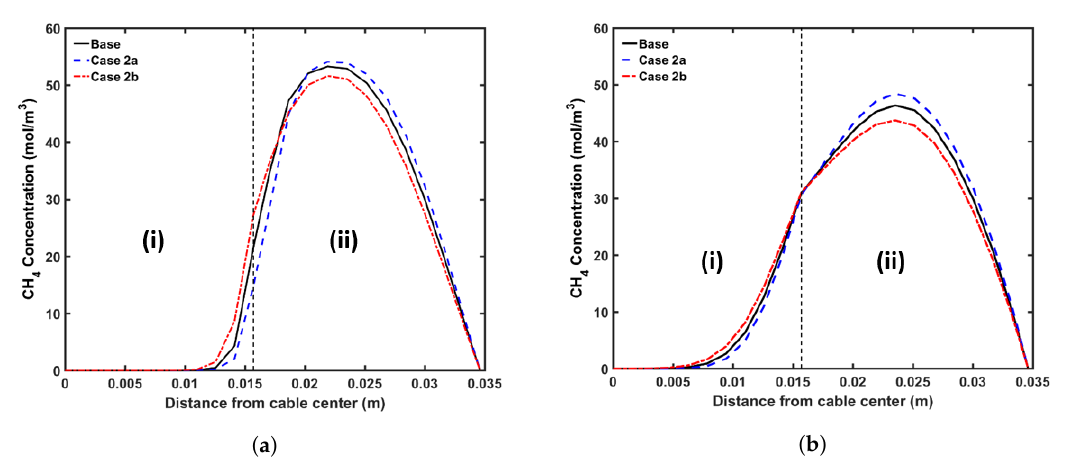
Figure 13. Axial CH 4 concentration profile across the CV line for the line speed study. The black line represents the base case, the blue line in ( a ) represents Case 2a, and the red line in ( b ) represents Case 2b. Segments (I), (II) and (III) correspond to the curing tube and transition zone, water-cooling, and air-cooling segments, respectively.